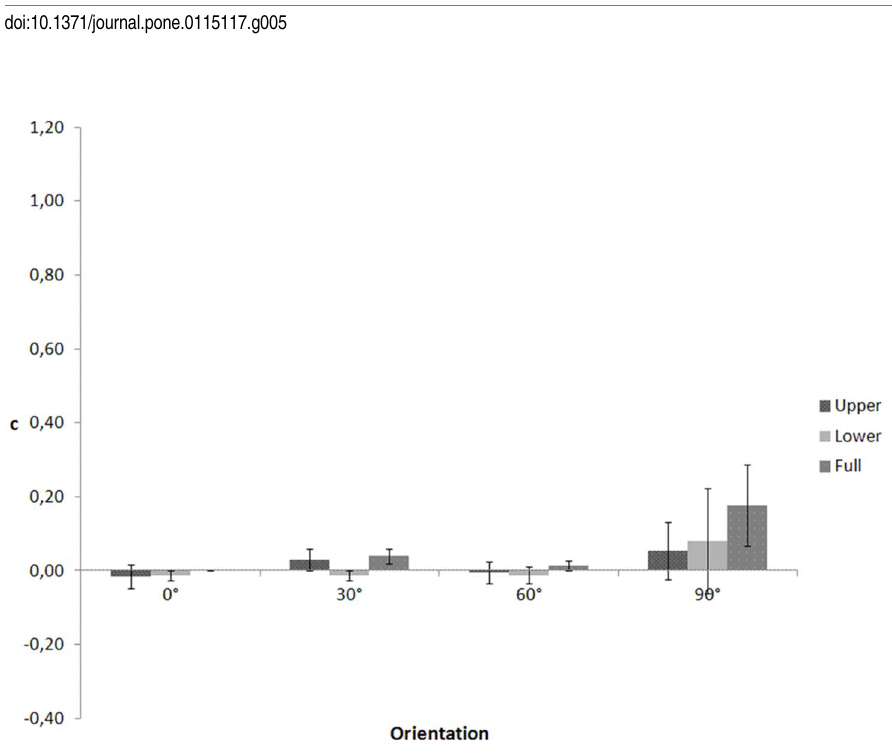
Fig. 5. d’ as a function of visible body part and figure orientation for the crawling action in Experiment 3.